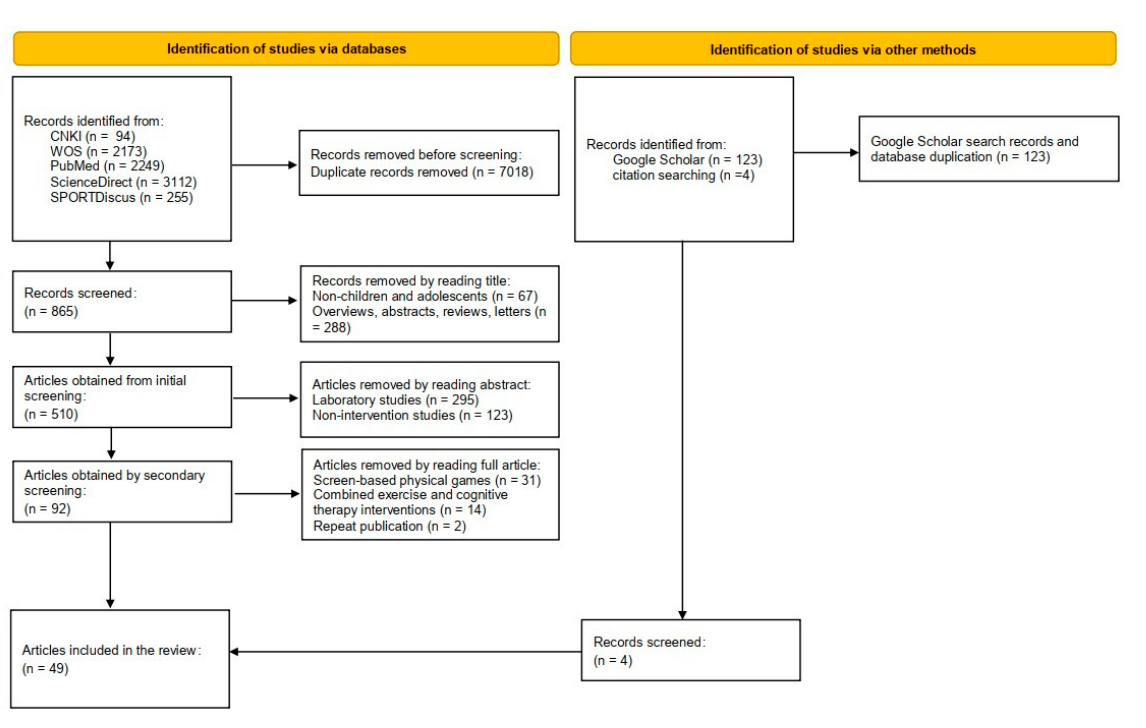
Figure 1. Literature-selection process according to the PRISMA 2020 guideline.